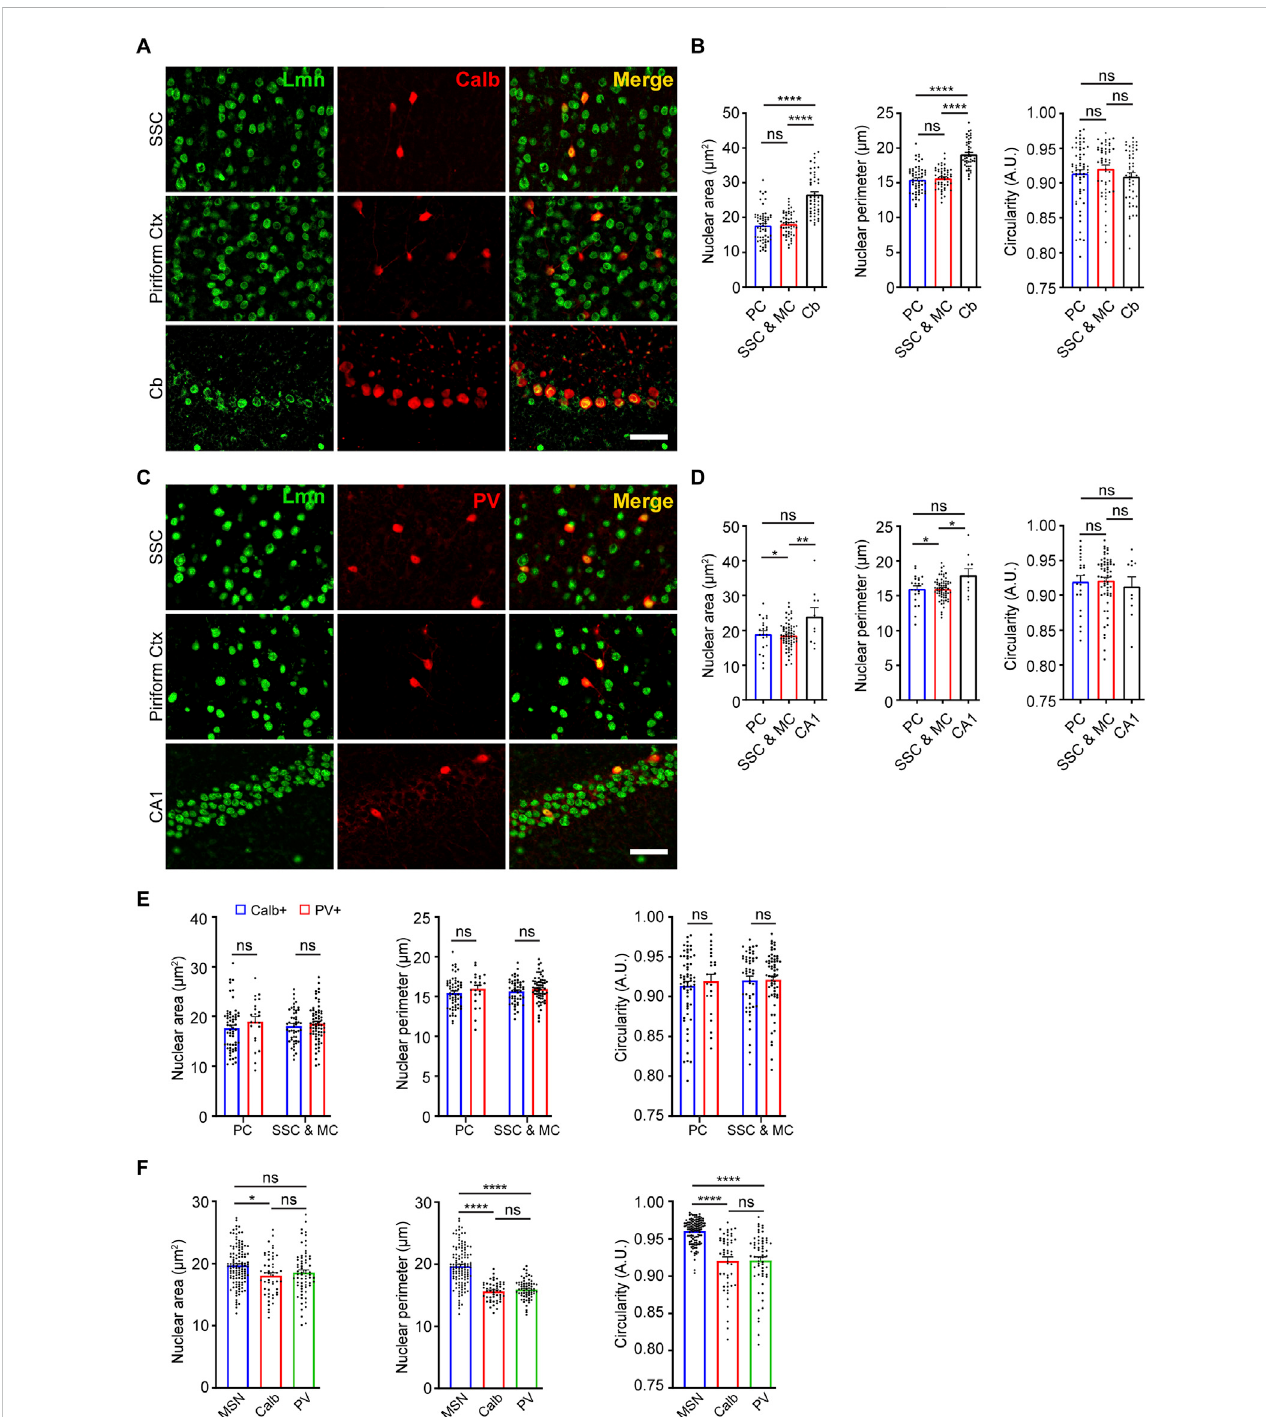
FIGURE 3 Nuclear morphology of Calbindin-positive and Parvalbumin-positive neurons. (A) Immunostaining of brain sections from 3-month-old mice using anti- Lmn (green), anti-Calbindin (red) along with DAPI (blue). Scale bar, 25 µm. (B) Mean nuclear area, nuclear perimeter, and nuclear circularity of Calbindin- positive neurons in the somatosensory cortex, motor cortex, piriform cortex, and cerebellum. (C) Immunostaining of brain sections from 3-month-old mice using anti-Lmn (green), anti-Parvalbumin (red) along with DAPI (blue). Scale bar, 25 µm. (D) Mean neuronal nuclear area, perimeter, and circularity of Parvalbumin-positive neurons in the somatosensory cortex, motor cortex, piriform cortex and hippocampal CA1. (E) Comparison of mean nuclear area, perimeter, and circularity between calbindin-positive and parvalbumin-positive interneurons in the piriform cortex, somatosensory cortex, and motor cortex at 3 months. (F) Comparison of mean nuclear area, perimeter, and circularity of striatal medial spiny neurons, Calbindin- and Parvalbumin-positive interneurons in the somatosensory, and motor cortex at 3 months of age. One-Way ANOVA (* p < 0.05, ** p < 0.01, *** p < 0.001 and **** p < 0.0001). n = 3mice.Datarepresentedasmean±SEM.PC,piriformcortex;SSC,somatosensorycortex;MC,motorcortex;MSN,medialspinyneurons;Calb,calbindin;PV,